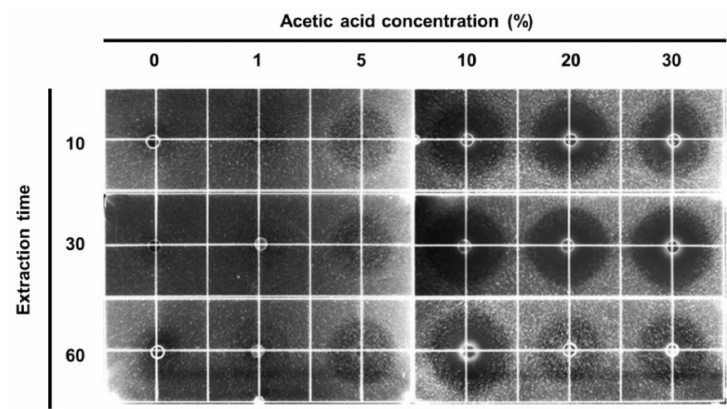
Figure 1. Determination of acetic acid concentration and incubation time to prepare defatted HIL extracts from crude-oil-extracted crushed HIL powder. HIL were grown for 11 days and then crude- oil-extracted HIL were prepared through the extraction of crude oil from HIL by an expeller extractor. Each batch of crude-oil-extracted, crushed HIL powder was incubated in various concentrations of acetic acid solution (0–30%) for 10, 30, or 60 min to isolate the extract. Each extract was dissolved in 0.05% acetic acid solution, and 10 µ L of the extract was loaded into the wells in the underlay gel and incubated for 24 h to determine antimicrobial activity using